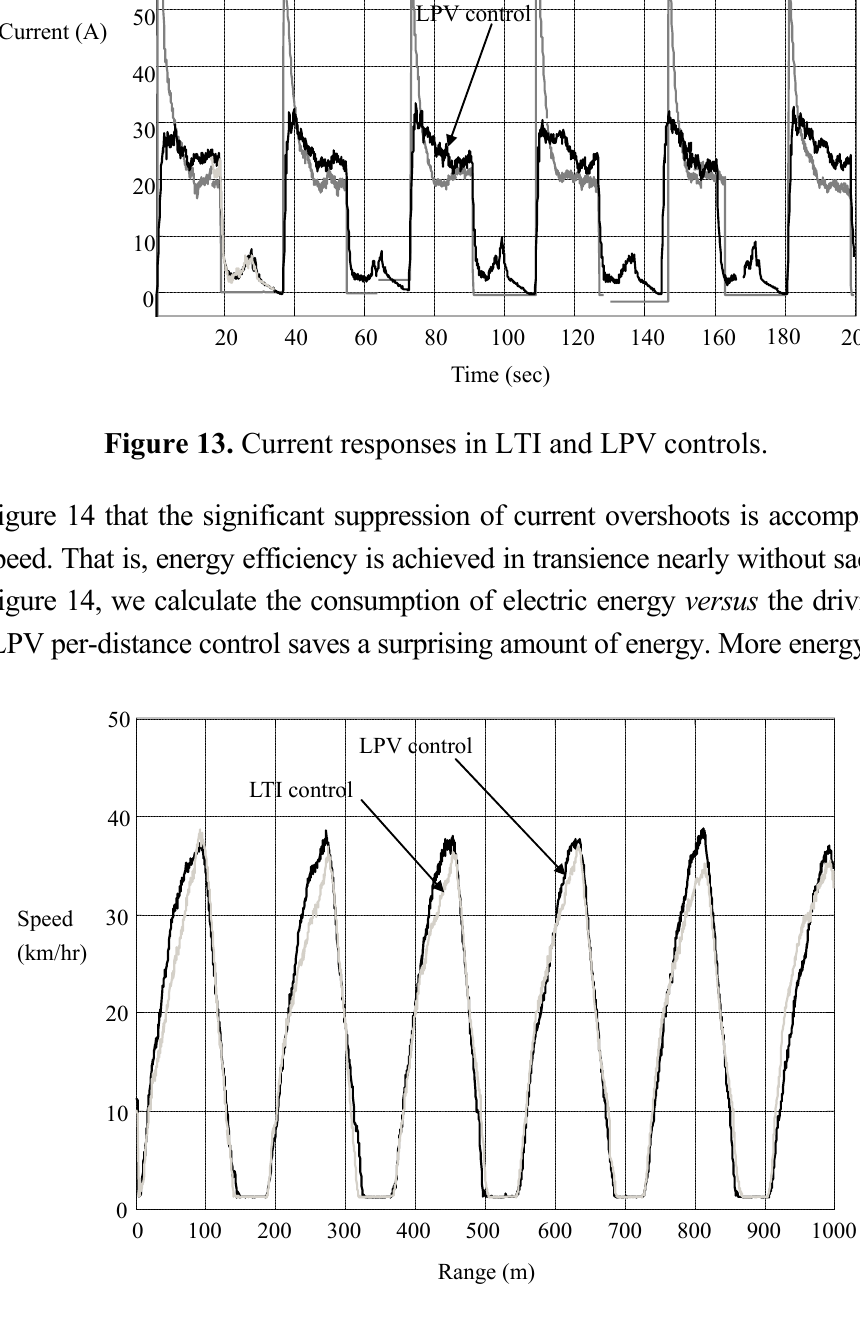
Figure 14. Motion responses in LTI and LPV